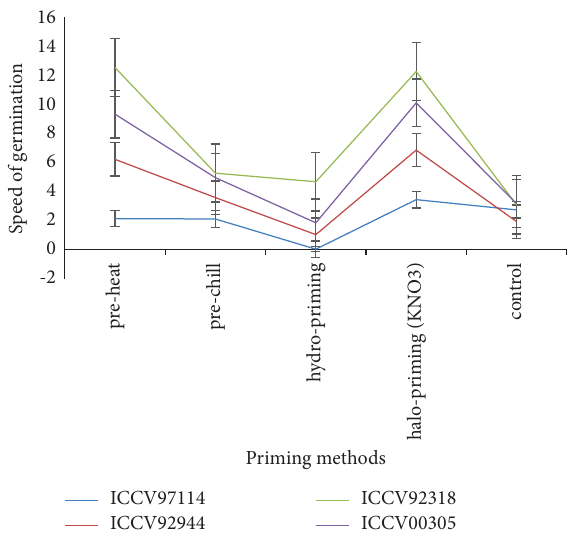
Figure 2: Efect of seed priming × variety on the speed of ger- mination of chickpea. Vertical bars represent standard error bars of